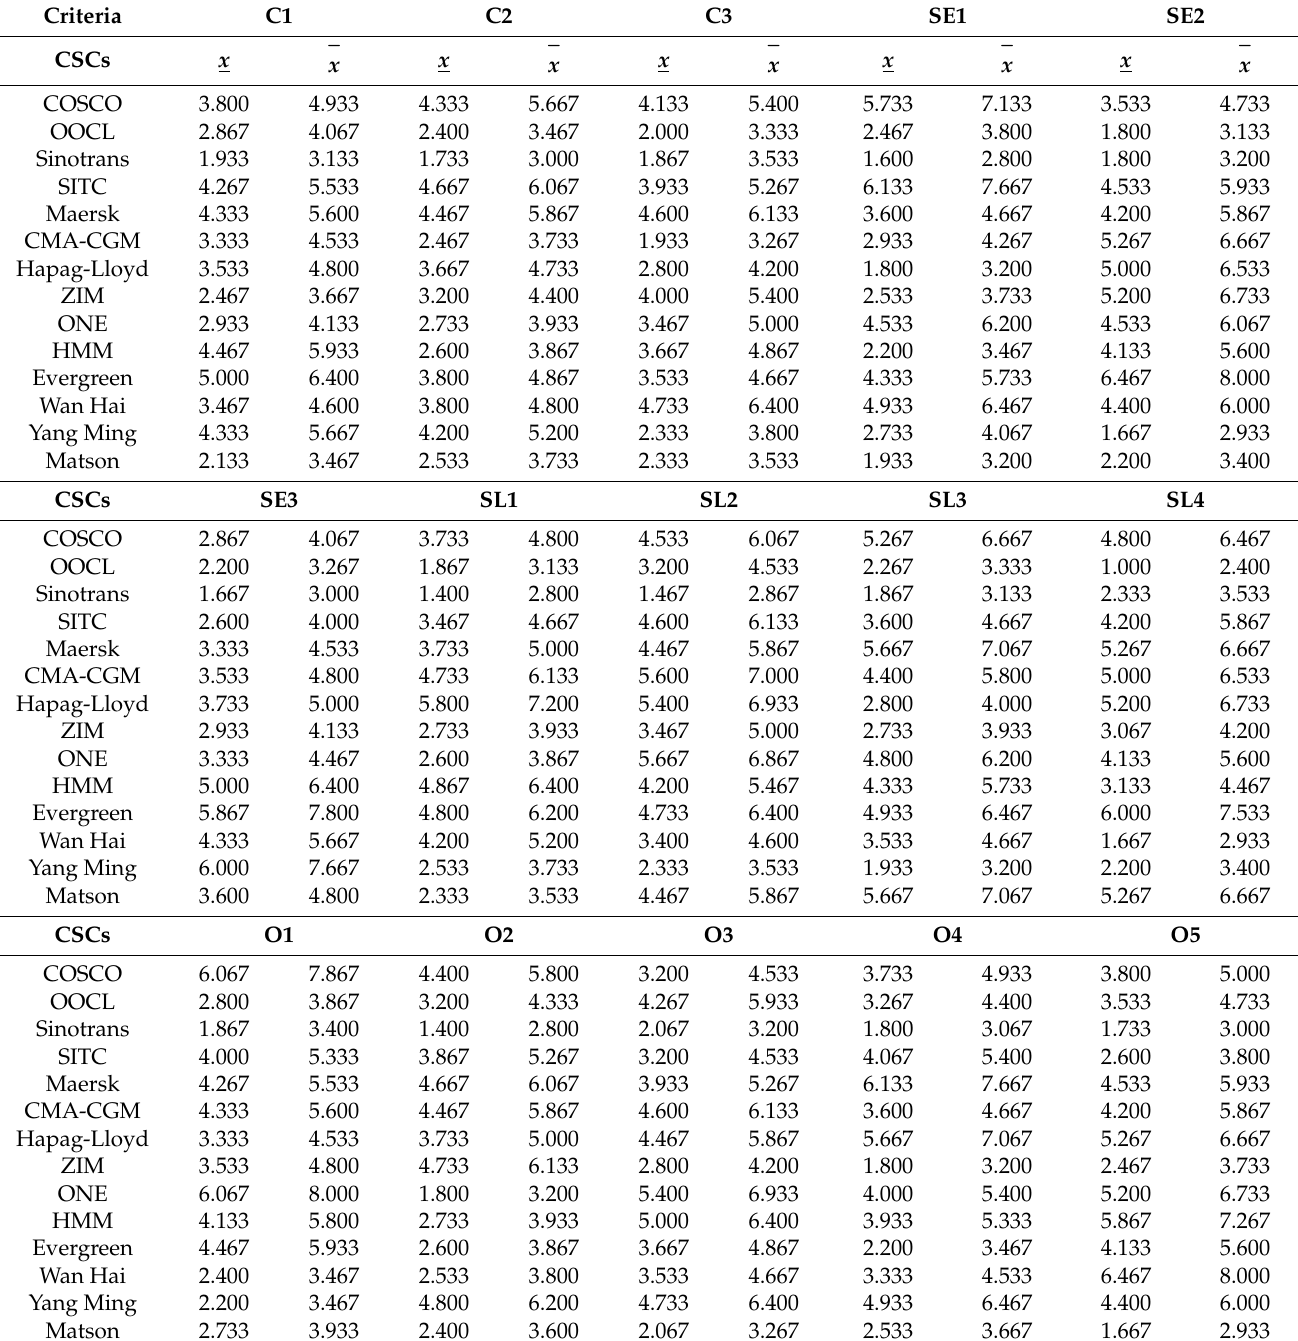
Table A2. The integrated grey decision matrix of the G-COPRAS model.